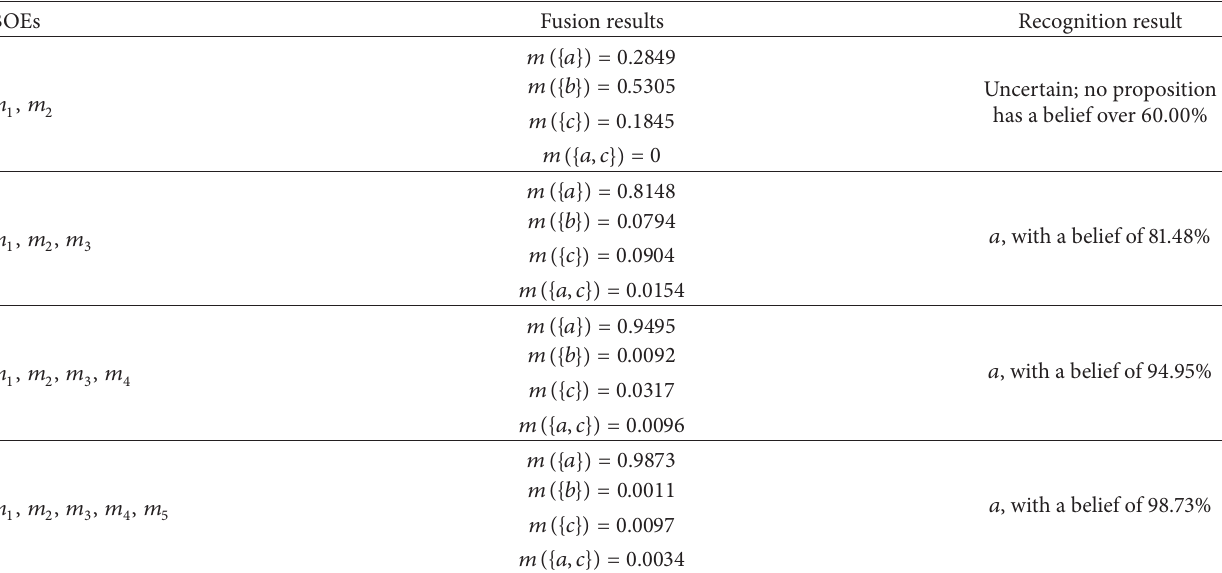
Table 4: Decision-making results based on sensor data fusion.